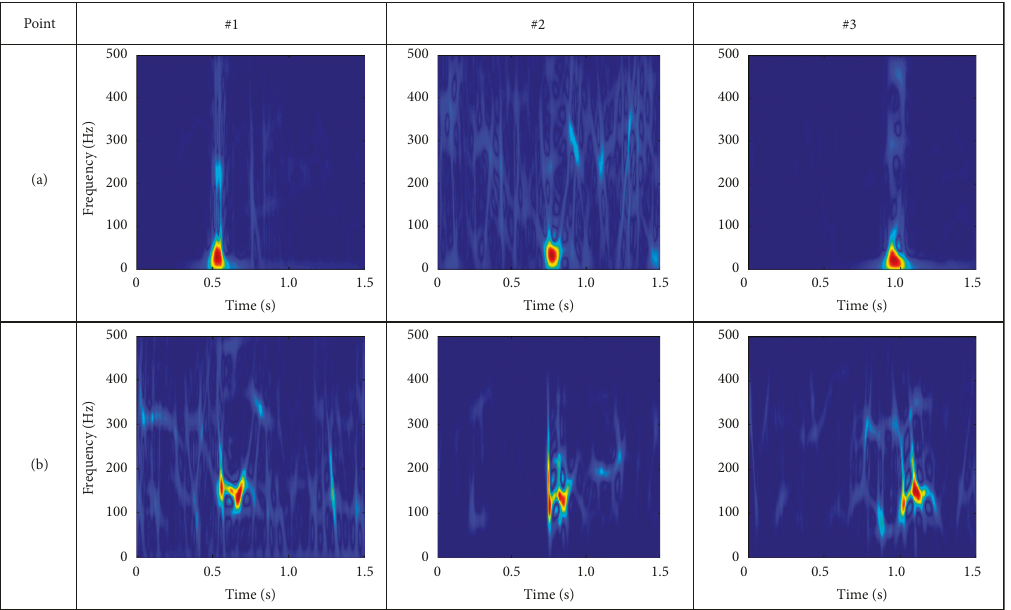
Figure 13: Time-frequency representation of vibration signals under empty load: (a) chain jam; (b) chain fracture.